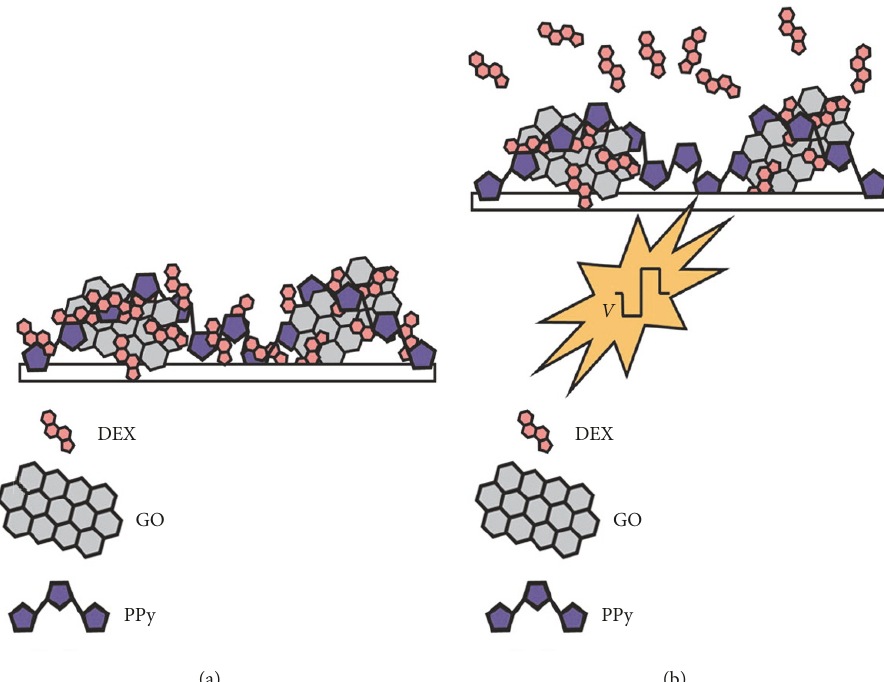
Figure 5: Schematic representation of the (a) GO/PPy-DEX nanocomposite and (b) DEX release from the GO/PPy nanocomposite in response to electrical stimulation [124].